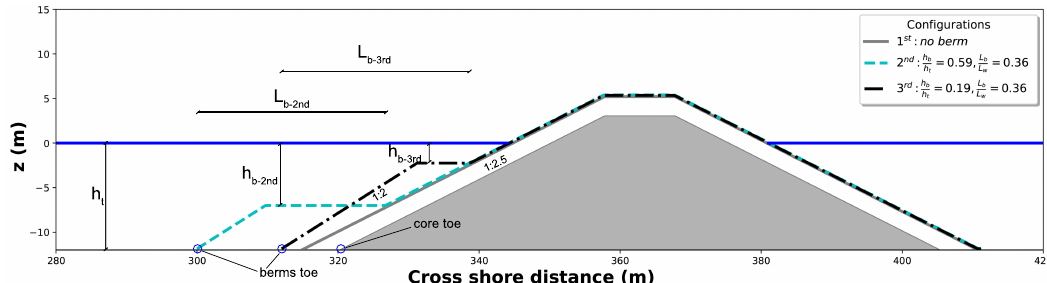
Figure 1. Tested geometric configurations: a rubble mound breakwater without a berm and two rubble mound breakwaters with submerged berms characterized by h b / h t = 0.590, L b / L w = 0.356, and h b / h t = 0.190, L b / L w = 0.356, respectively.